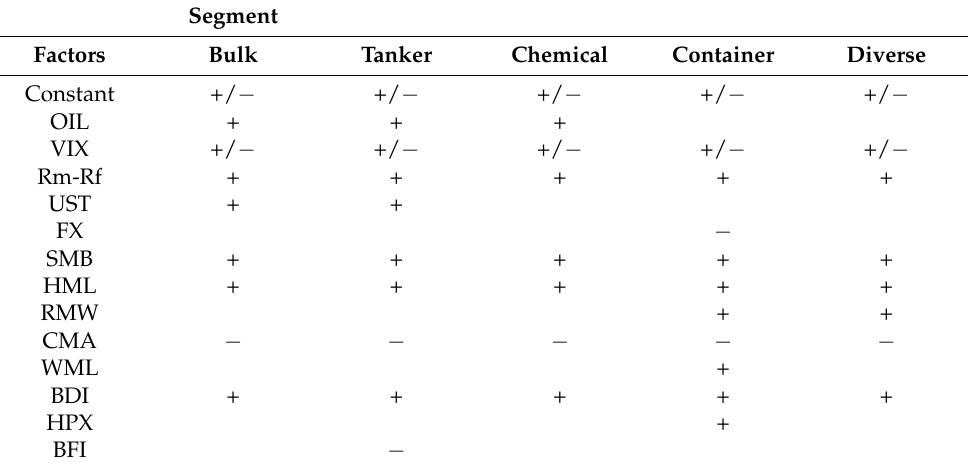
Table 10. Summary of significant effects from factor by shipping segment (quantile